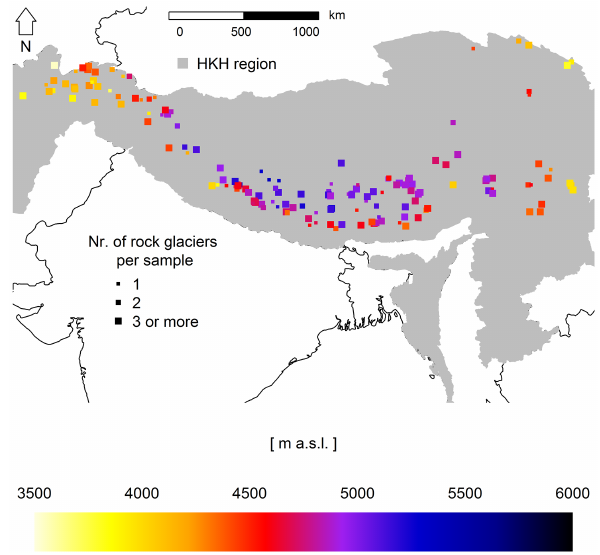
Figure 5. Mean minimum elevation of rock glaciers per sample. The size of the square indicates how many rock glaciers this value is based on. This is for 24% one rock glacier, for 18% two rock glaciers, and for 58% between 3 and 21 rock